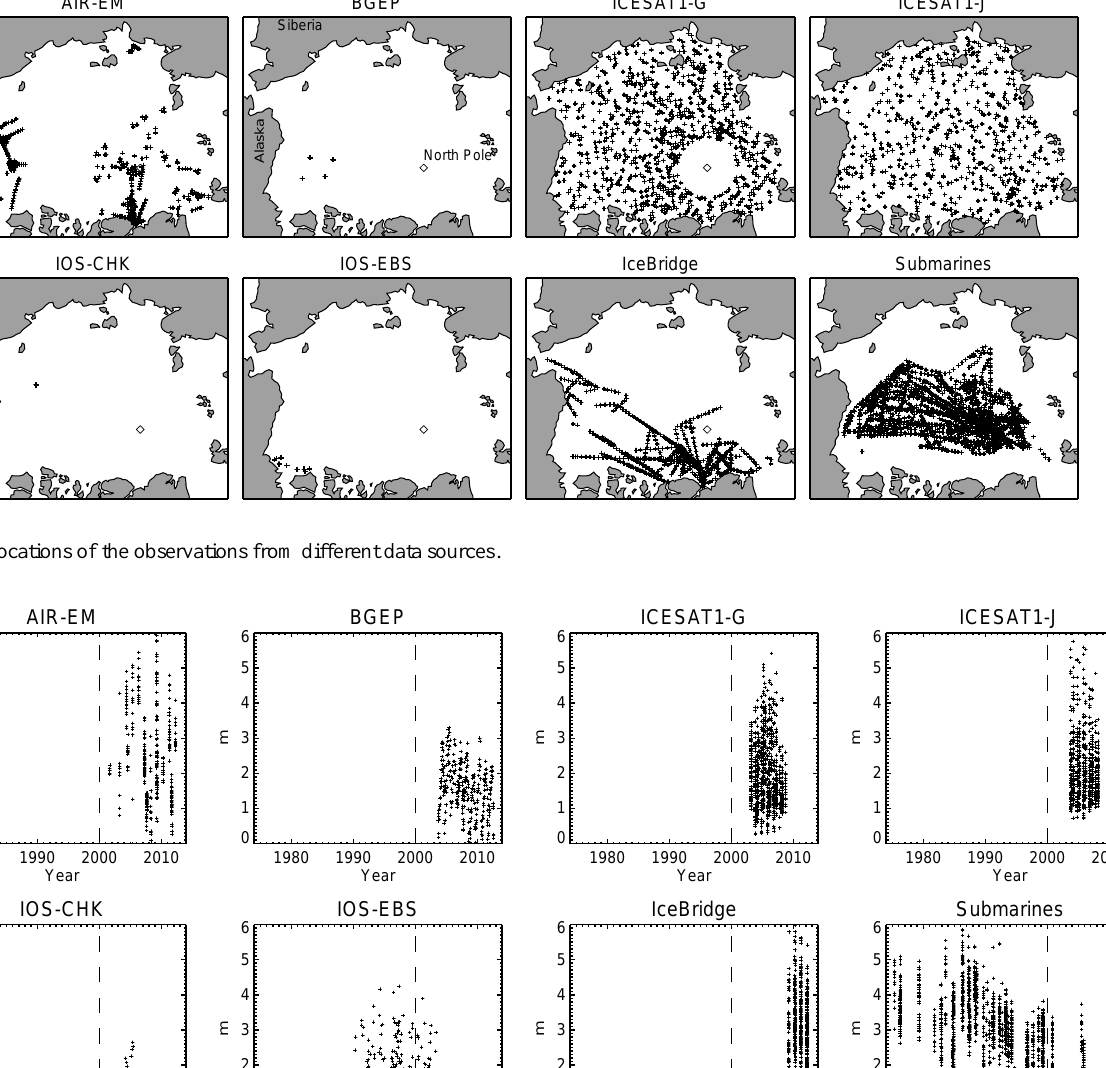
ments reported for the submarines have a likely bias of 0.29 ± 0.25 m. The error range includes the error con- tributions from other unbiased sources of error